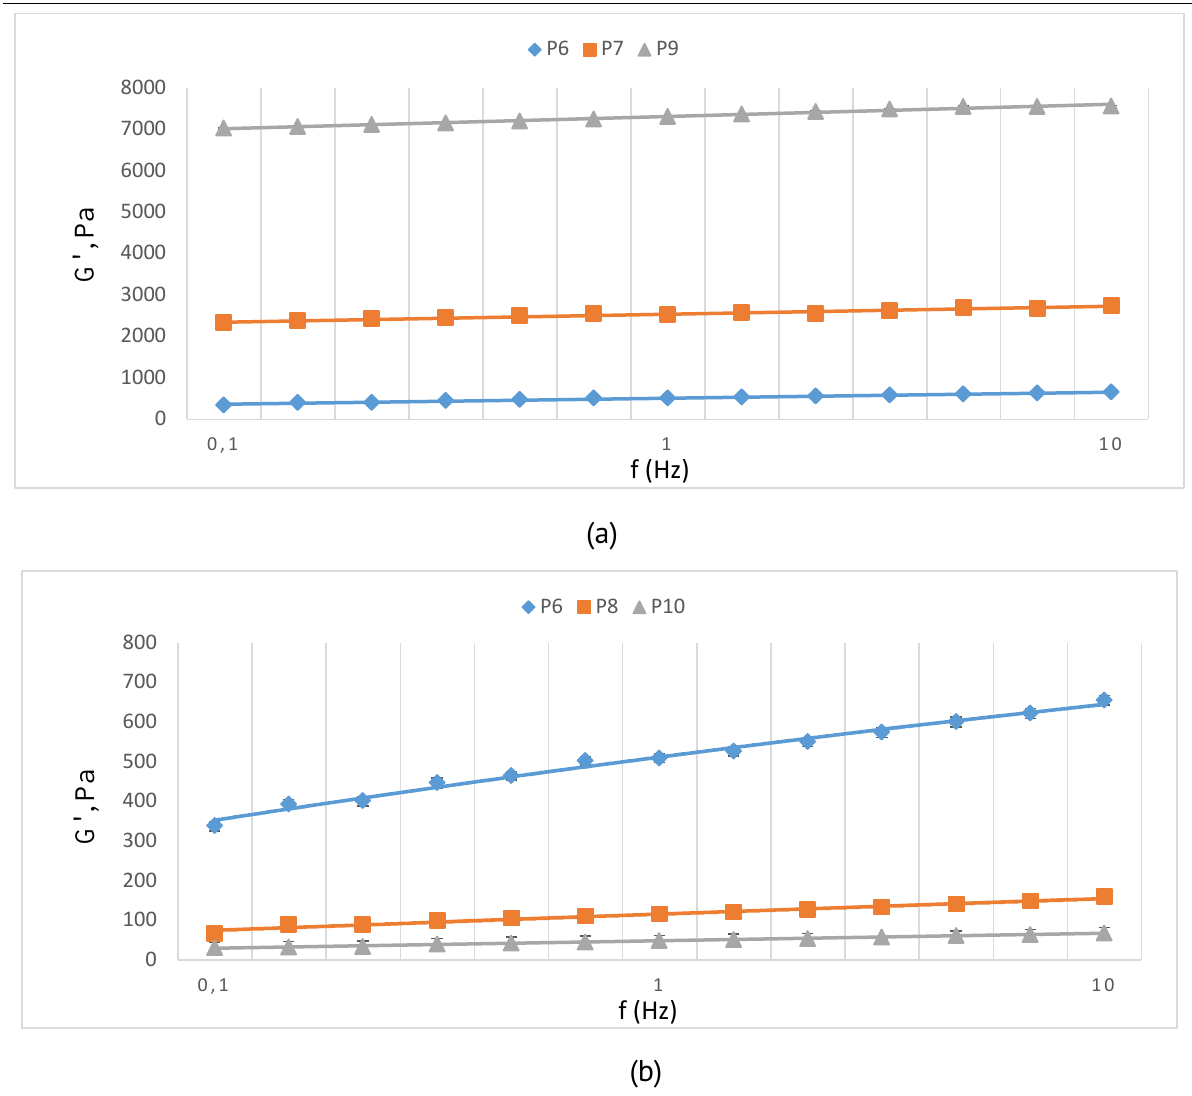
Figure 2. Viscoelastic parameters (G ' ) from frequency of yogurts, series II, (a, b).